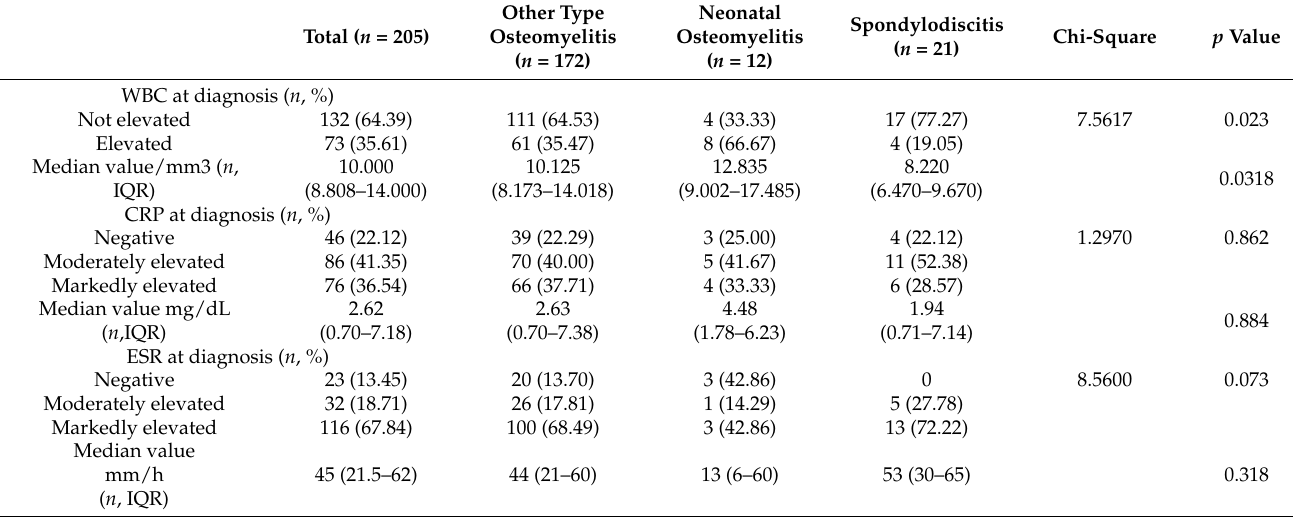
Table 3. White cells count, C-reactive protein and erythrocyte sedimentation rate values at diagnosis. Total ( n =